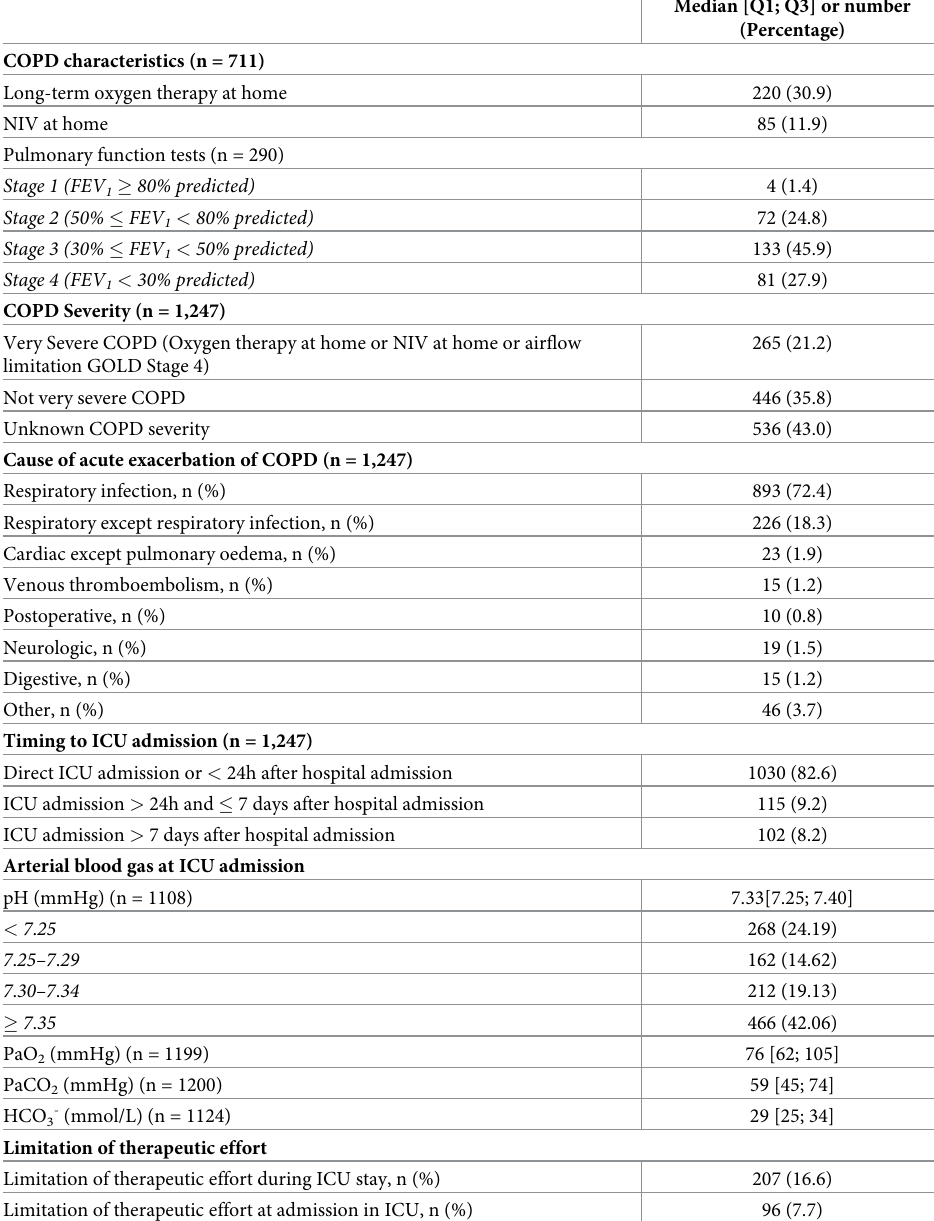
Table 2. Characteristics of past medical history and COPD